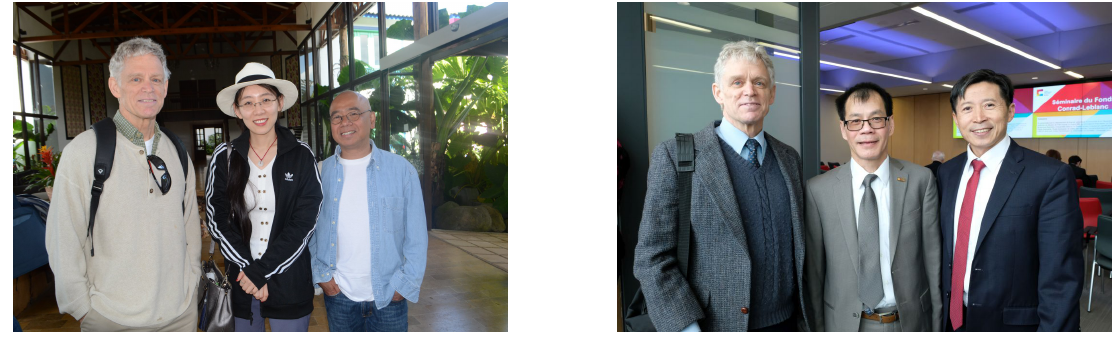
Figure 6: The left-hand picture is Jed with young (relative to Jed) researcher Fangda Liu and his long-time collaborator, Emil- iano Valdez. They are participating in the Third International Congress on Actuarial Science and Quantitative Finance, 2019, Manizales, Colombia. The right-hand picture is Jed with host Van Son Lai and Shaun Wang at the Séminaire 2018 du Fonds Conrad-Leblanc held at Université Laval in Québec,